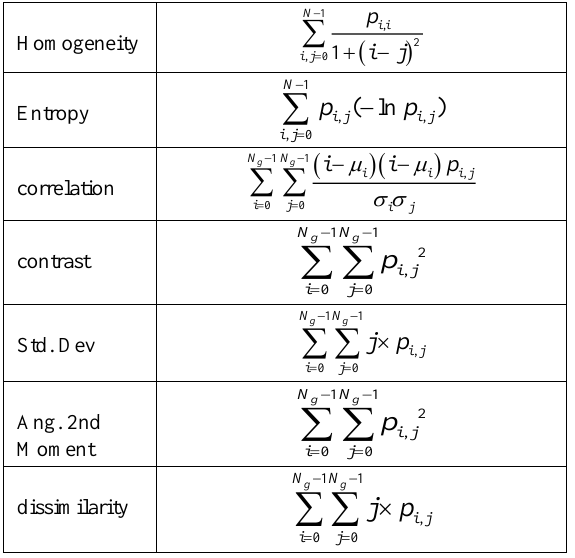
Table1. Applied textural features for change detection Homogeneity